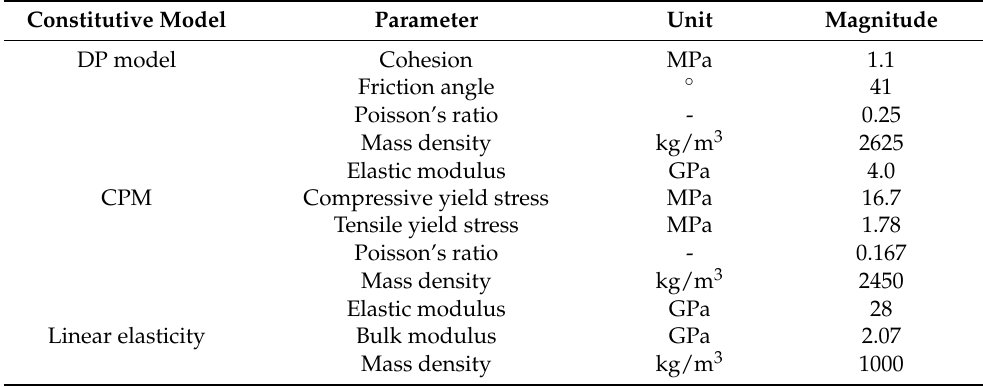
Table 1. Mechanical parameters of surrounding rock, water, and concrete lining. Constitutive